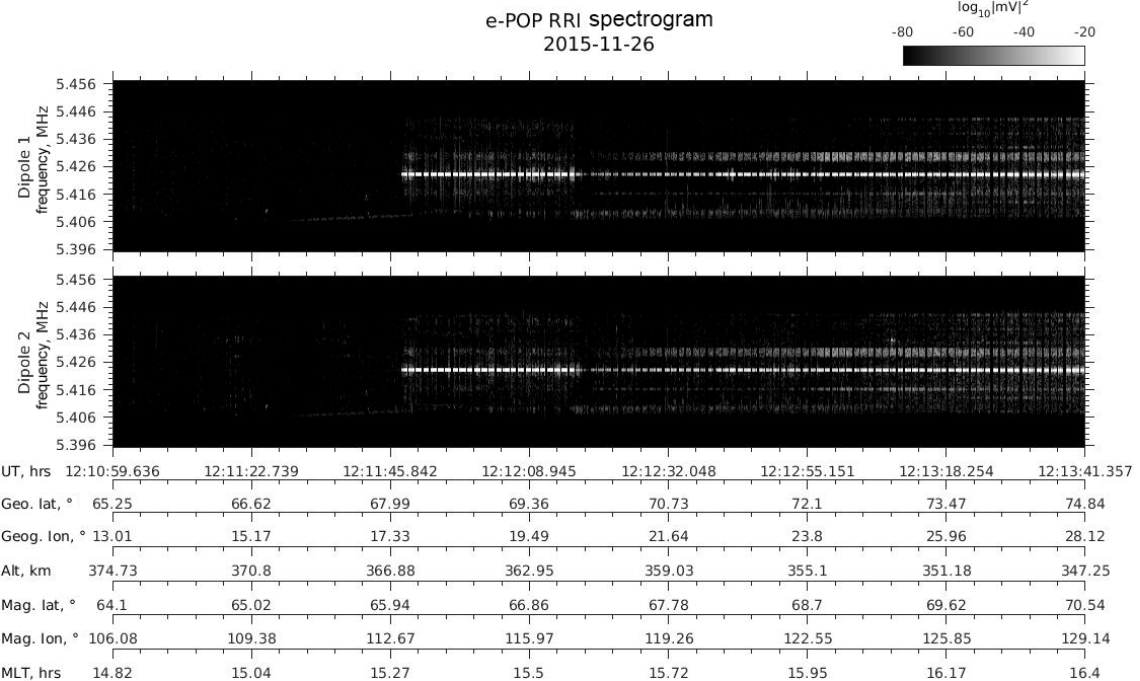
Figure 5. Overview of the detected voltage on the two antenna dipoles for the CASSIOPE passage over EISCAT Heating from 12:10:59.636 to 12:13:41.357UT on 26 November 2015. The RRI was pre-programmed to sweep between 13 different frequency bands, one of which contained the Heating signal at f 0 = 5 . 423MHz. The two panels show the signal level in the 60kHz wide frequency band around the Heating signal at f 0 , which can be seen from about 12:11:45UT.